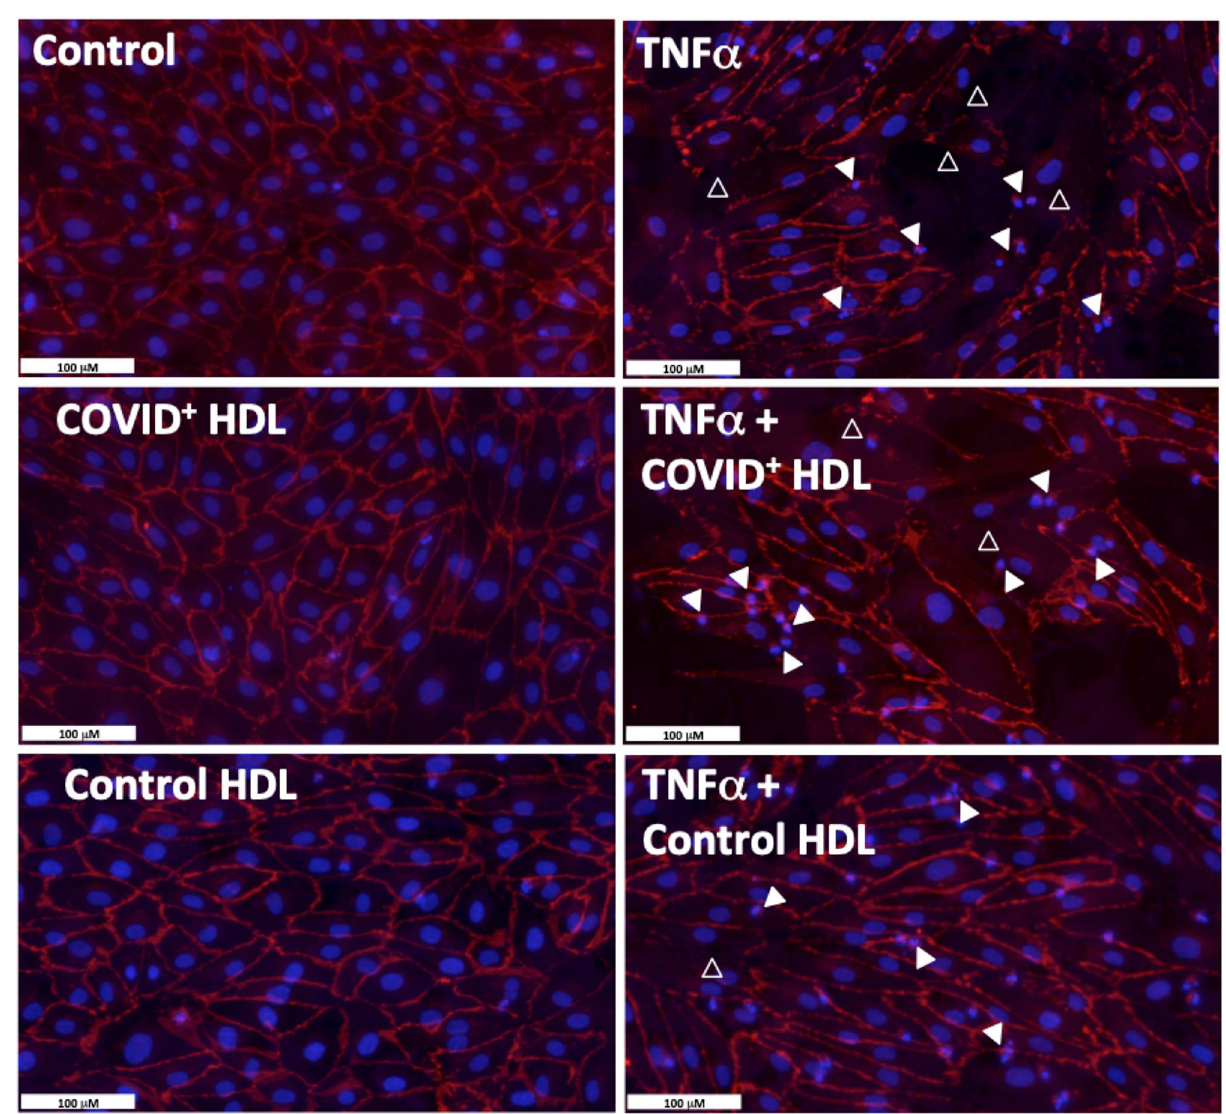
Figure 5. Effect of HDLs from controls and COVID-19 (C+) subjects on HUVEC apoptosis cells after stimulation with 30 ng/mL TNFα for 24 h. HDL were isolated from plasma of 16 controls and 8 D1 COVID-19 subjects by ultracentrifugation and pooled into two groups respectively “Control HDL" and “COVID+ HDL” Upper panel: immunostaining for VE-Cadherin (red) and nuclear staining with DAPI (blue). Empty white arrowheads show VE-Cadherin re-organization. Plain white arrowheads show examples of apoptotic nuclei (condensed and/or